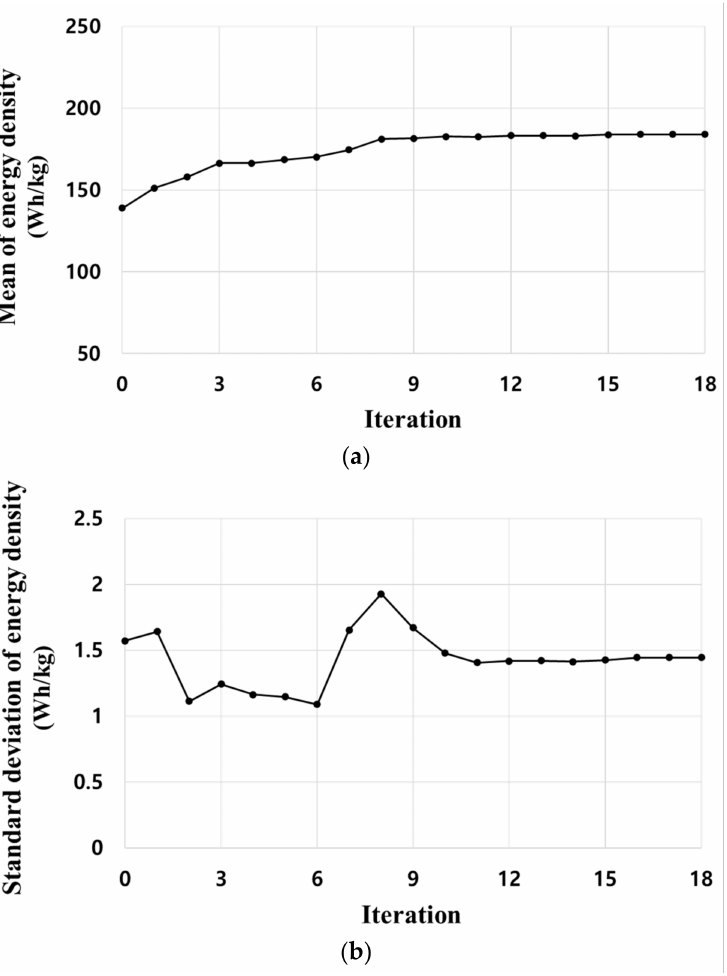
Figure 5. Convergence history for optimization of the objective functions related to the energy density: ( a ) mean and ( b ) standard deviation.